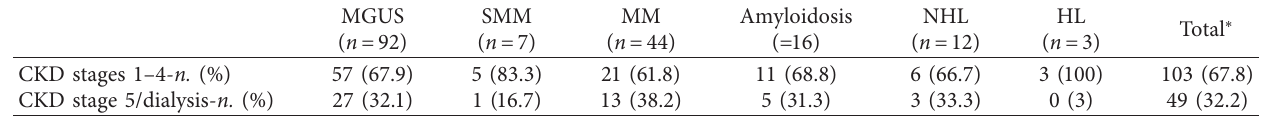
Table 5: Rate of end-stage renal disease or dialysis in patients with monoclonal gammopathy. MGUS